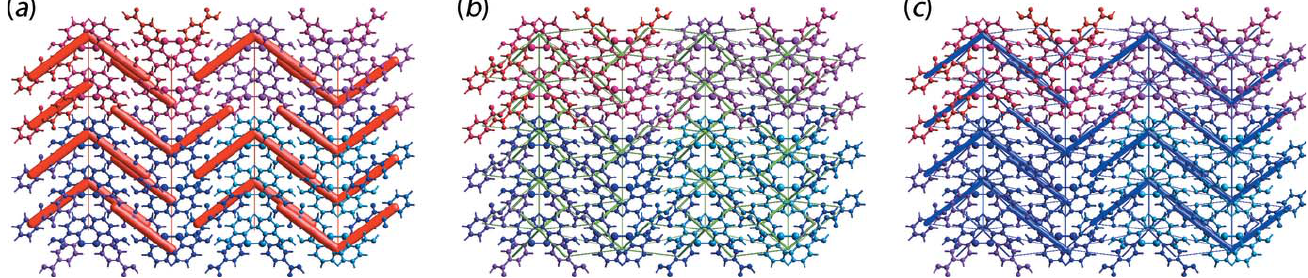
Figure 6 Energy framework of (I) as viewed down along the a -axis direction, showing the ( a ) electrostatic potential force, ( b ) dispersion force and ( c ) total energy diagrams. The cylindrical radii are proportional to the relative strength of the corresponding energies and they were adjusted to the same scale factor of 50 with a cut-off value of 5 kJ mol (cid:3) 1 within 4 (cid:7) 4 (cid:7) 4 unit